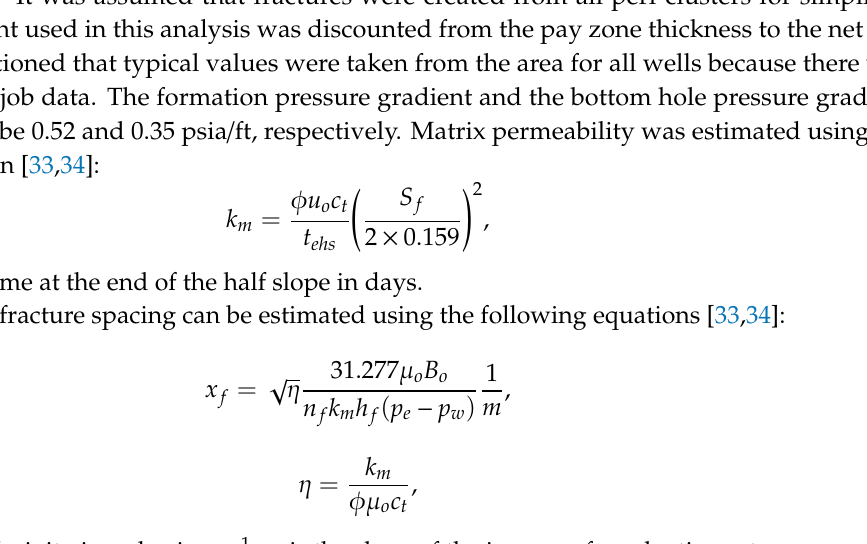
Figure 8. Plot of production rate data for Well #3.